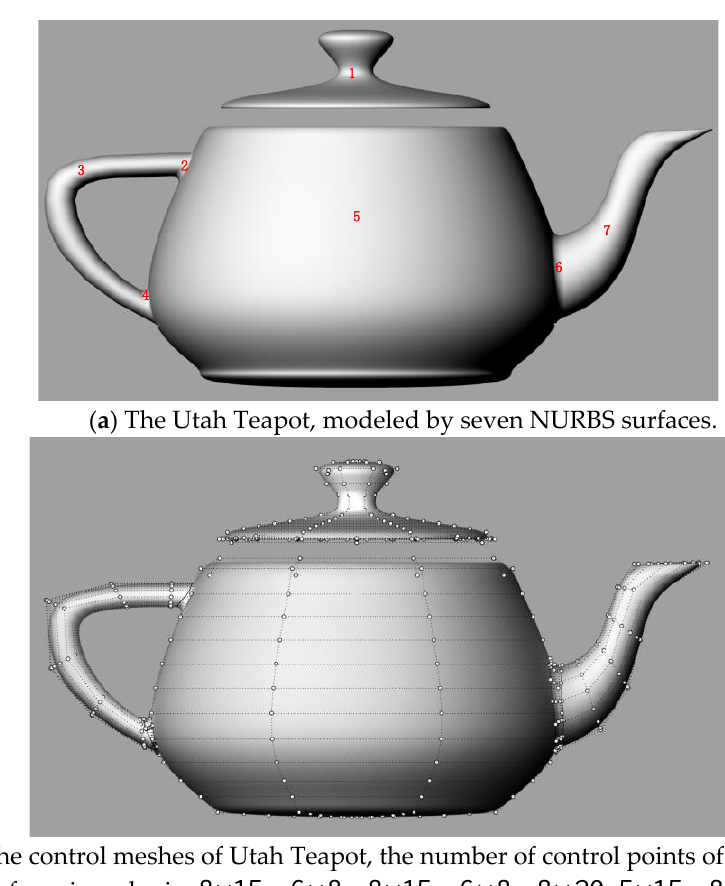
Figure 13. Utah Teapot, the symbol of computer graphics.